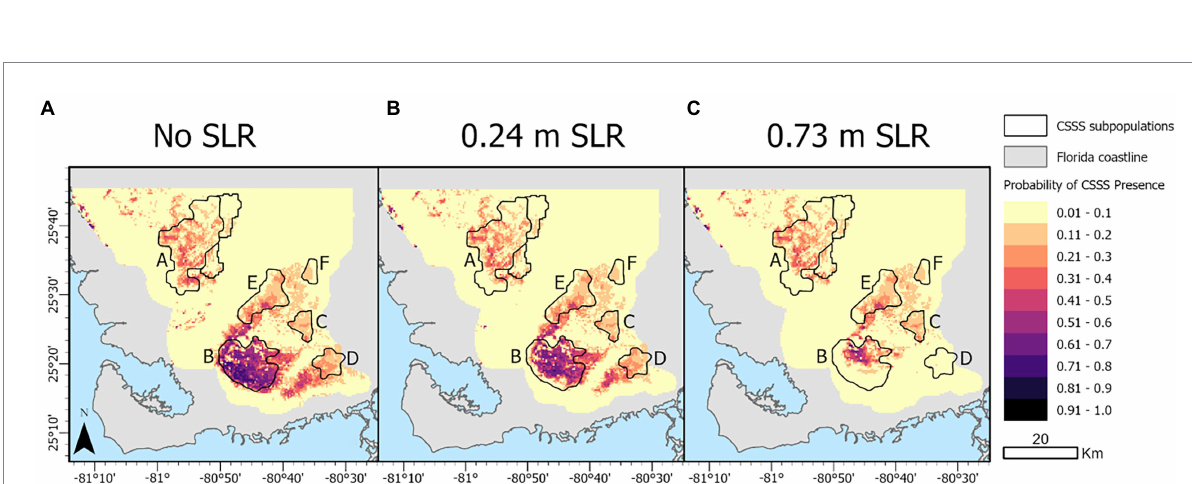
FIGURE 3 Maps showing the EverSparrow mean probability of presence for the Cape Sable seaside sparrow ( Ammospiza maritima mirabilis ; CSSS) during the breeding season (March – June) for the last year of three hydrologic scenarios: (A) a baseline (NA22f) without sea level rise (SLR), (B) the U.S. Army Corps of Engineers (USACE) intermediate SLR scenario (0.24 m in 50 years), and (C) the USACE high SLR scenario (0.73 m in 50